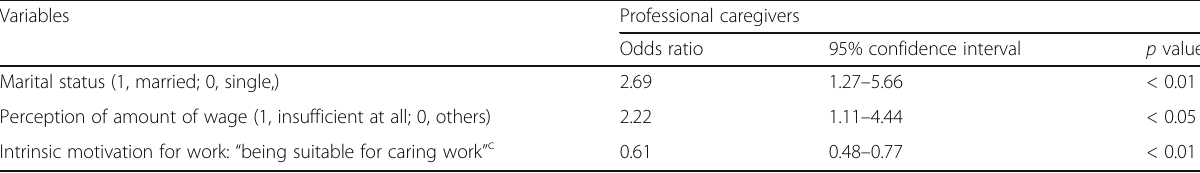
Table 5 multivariable logistic regression model for plan to resign from current occupation by the end of the year ( n = 667) a,b